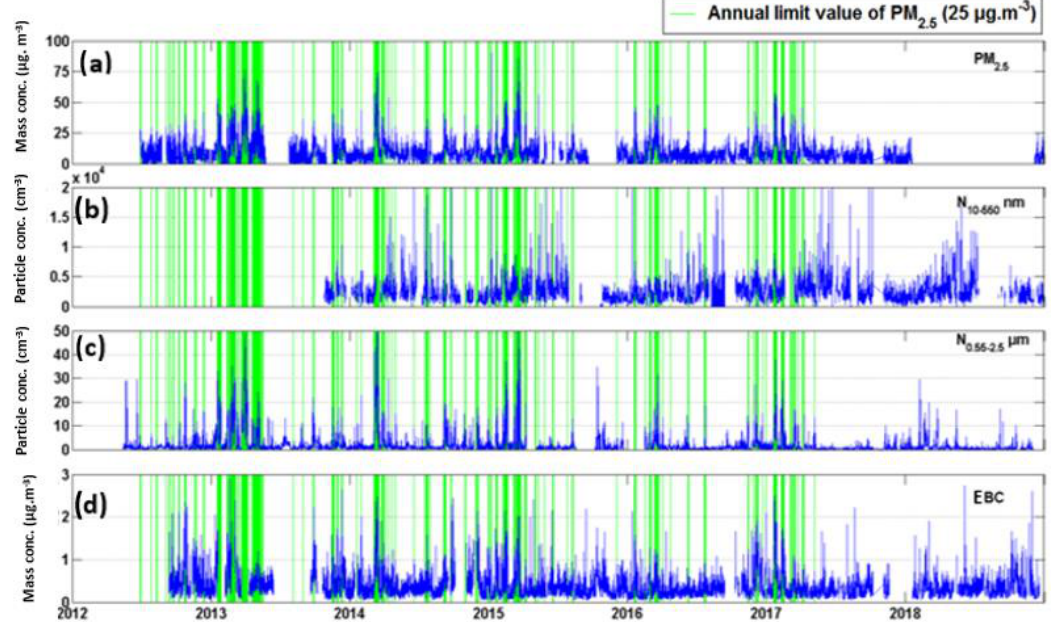
Figure 11. Time series of: ( a ) PM 2.5 ; ( b ) N 10–550 ; ( c ) N 0.55–2.5 ; ( d ) EBC, concentrations (Blue). Green bars indicate when mass concentrations exceed their annual limit value (25 µg.m −3 ).